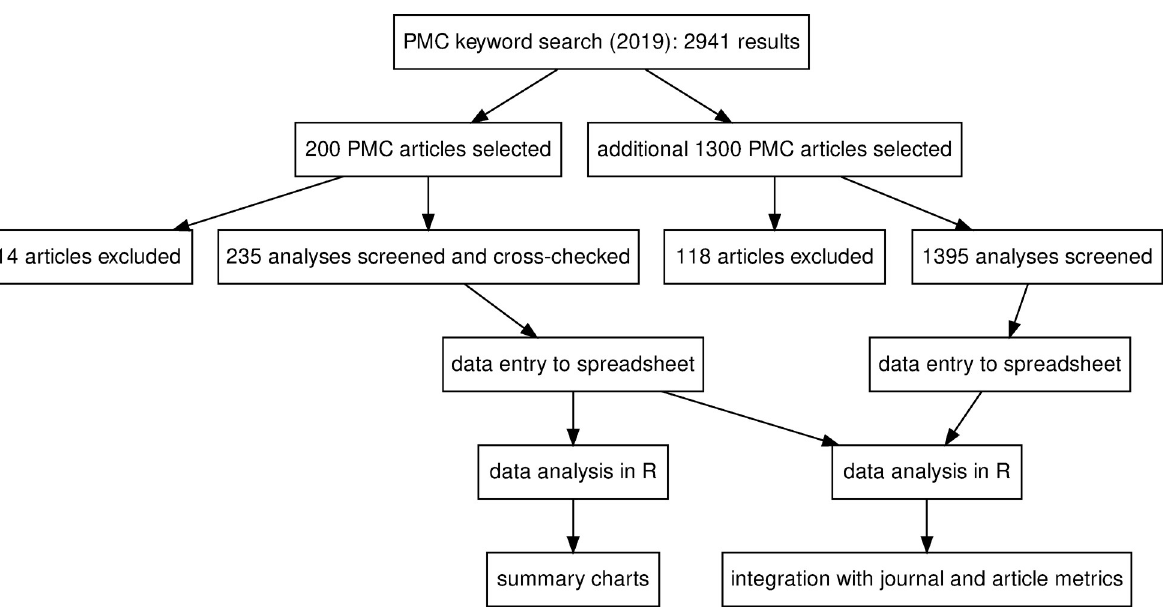
Fig 1. A summary of the survey of functional enrichment analyses. The survey consists of two parts, with 200 and 1300 PMC articles considered, respectively.